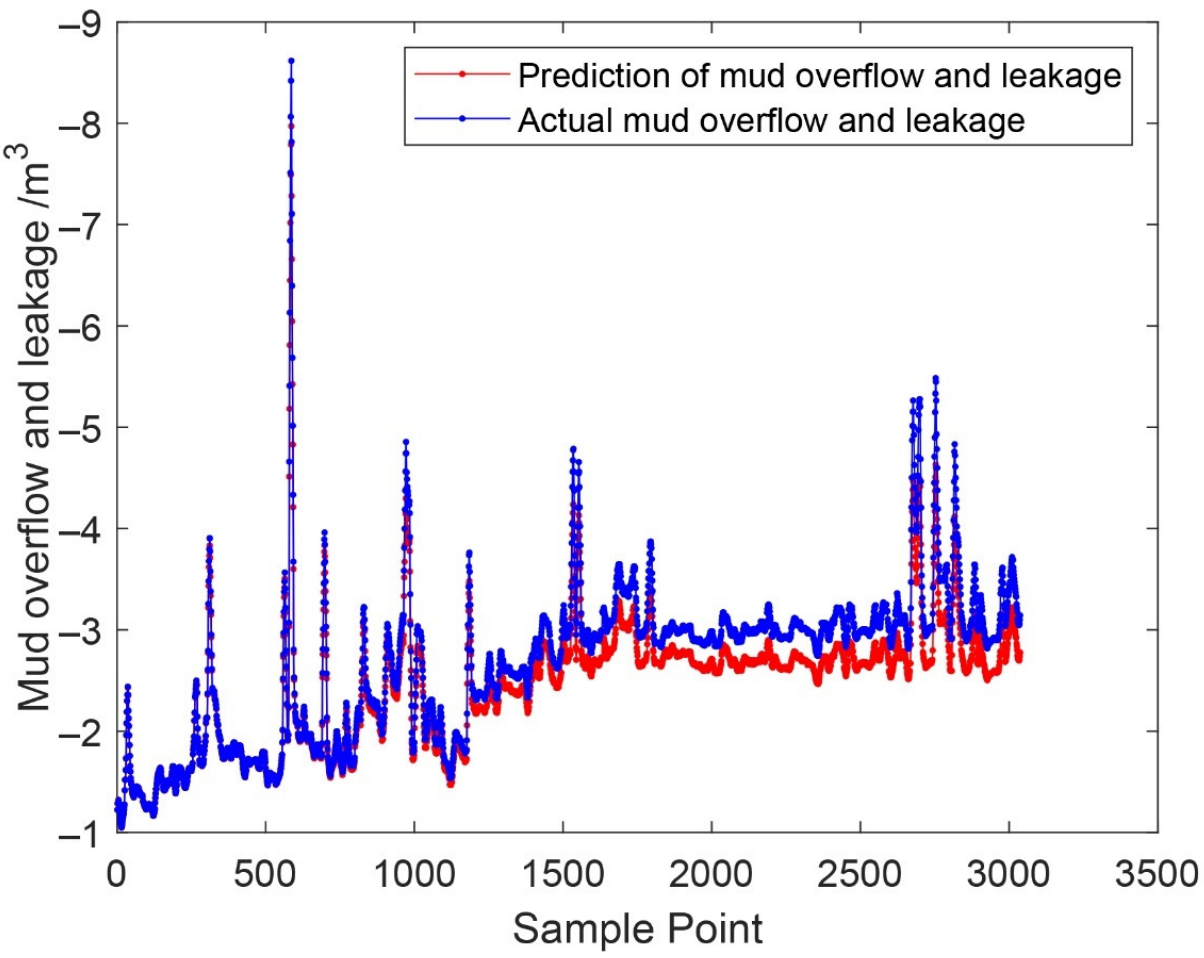
Figure 4. Mud overflow and leakage prediction results using BP neural network.